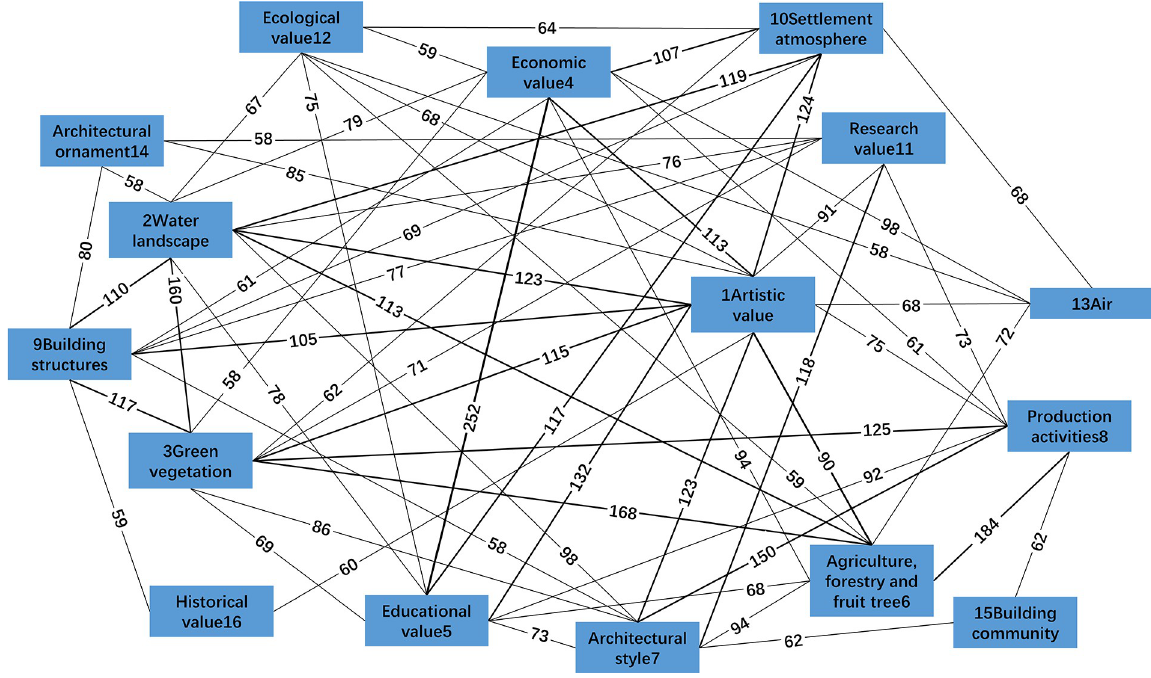
Fig 1. Semantic networks of traditional settlement cultural landscape